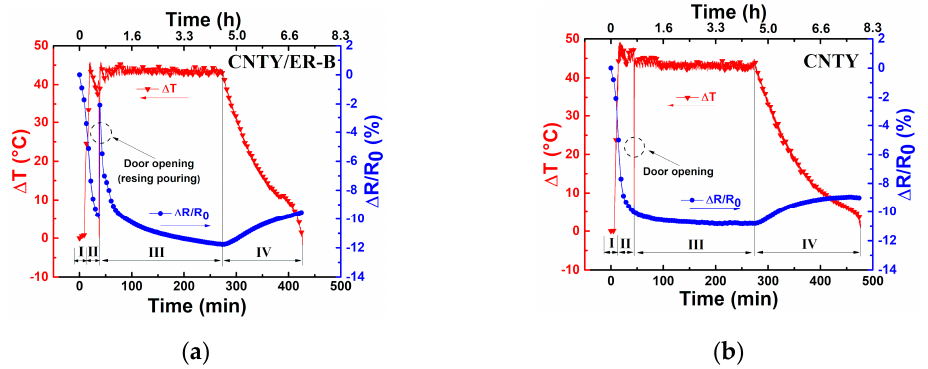
Figure 5. Change in electrical resistance and temperature during the curing process of ER-B. ( a ) CNTY/ER-B, ( b ) freestanding CNTY under the same temperature program.